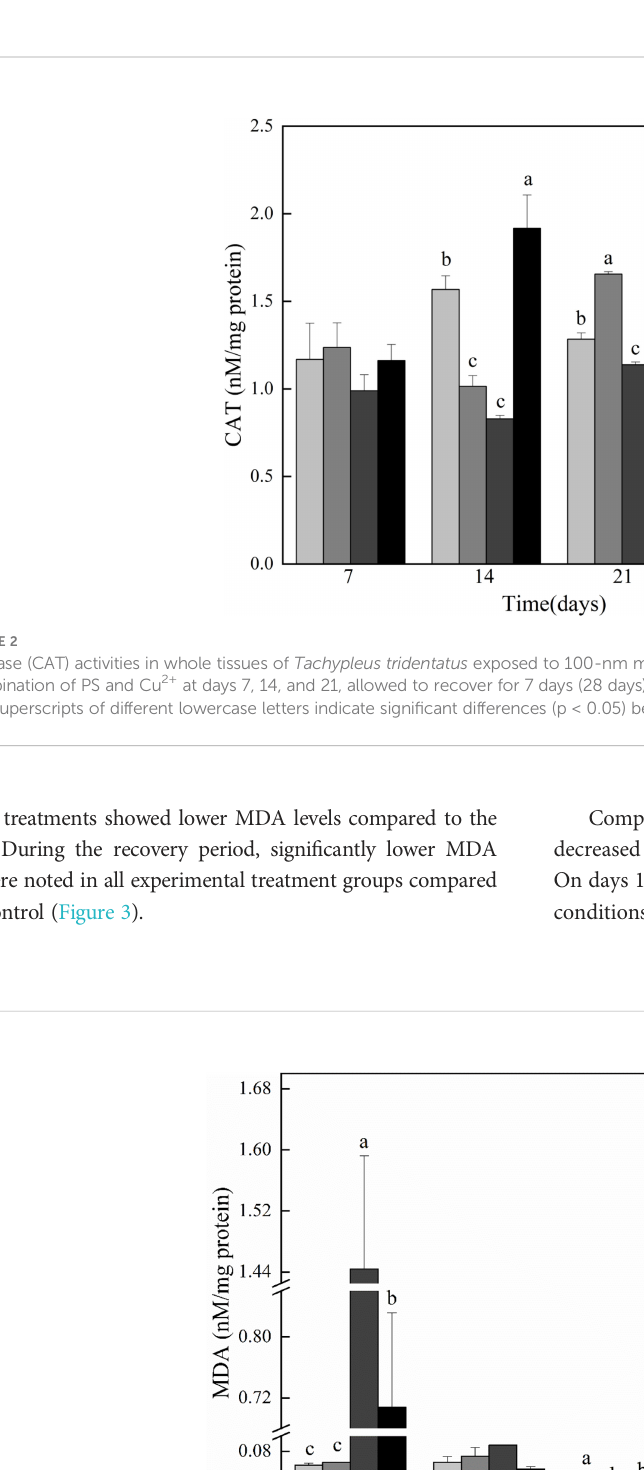
different treatments showed lower MDA levels compared to the control. During the recovery period, signi fi cantly lower MDA levels were noted in all experimental treatment groups compared to the control (Figure 3).